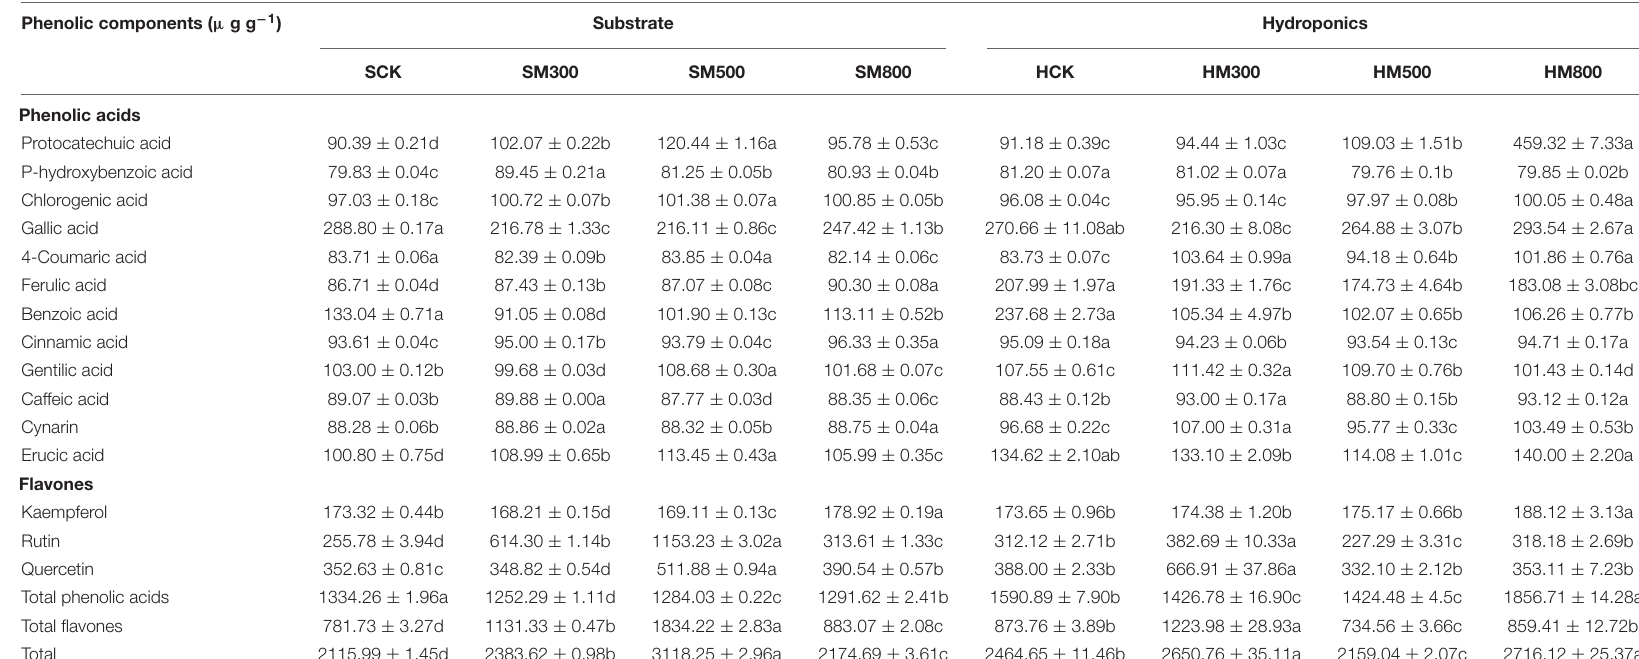
TABLE 5 | Effect of MeJA treatments on the phenolic component contents of substrate-grown and hydroponic Chinese